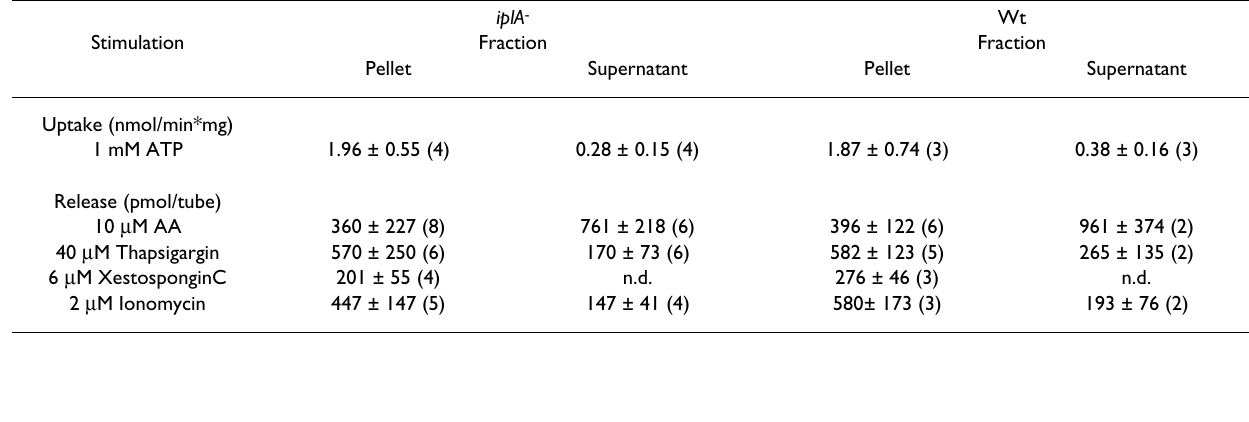
Table 1: Determination of Ca 2+ -fluxes in partially purified storage compartments of the iplA - mutant and of wild type. Ca 2+ - sequestering vesicles were prepared as outlined in Methods. Measurements were performed with the pellet and supernatant fraction. ATP-induced uptake and release activated by different agents is given as nmol Ca 2+ -uptake/min and mg of protein and pmol Ca 2+ - release/tube, respectively (mean ± s.d.). In release experiments 60–75 µ l of pellet and 120–140 µ l of supernatant fraction were used per tube. Numbers in brackets give number of experiments; n.d.: not determined.